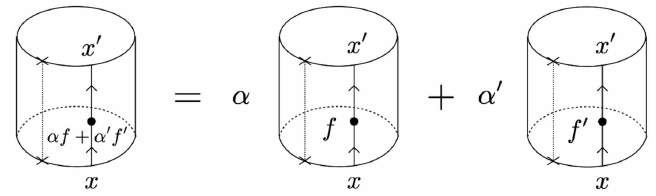
Figure 5 . The functor Z : C → Vec is C -linear in morphisms.